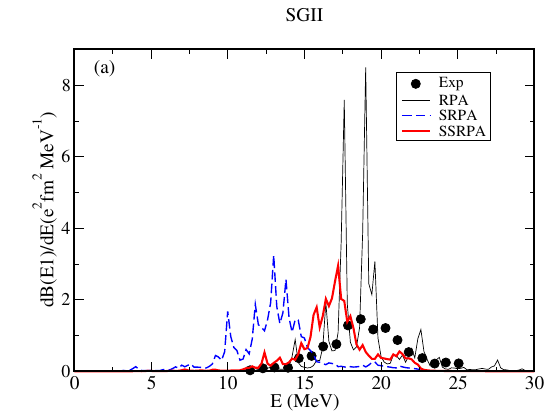
Figure 2. Dipole strength distributions in 48 Ca evaluated with RPA (solid black line), SRPA (blue dashed line), and SSRPA (thick red line), compared with the experimental distributions (black circles) from Ref. [19]. The SGII Skyrme interaction is